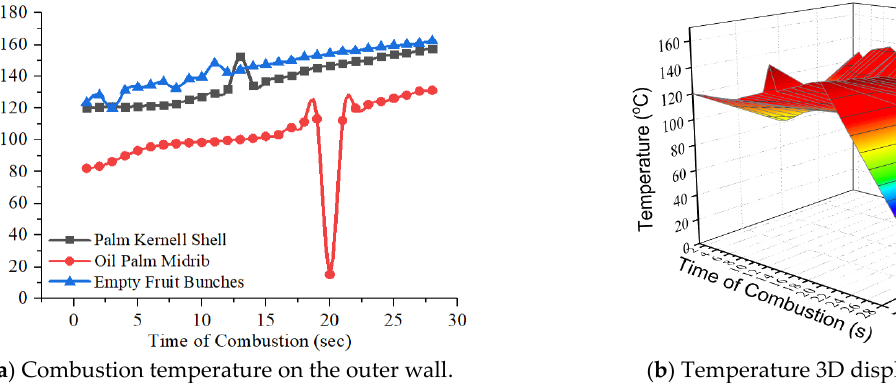
Figure 9. FBC wall temperature of different fuels.